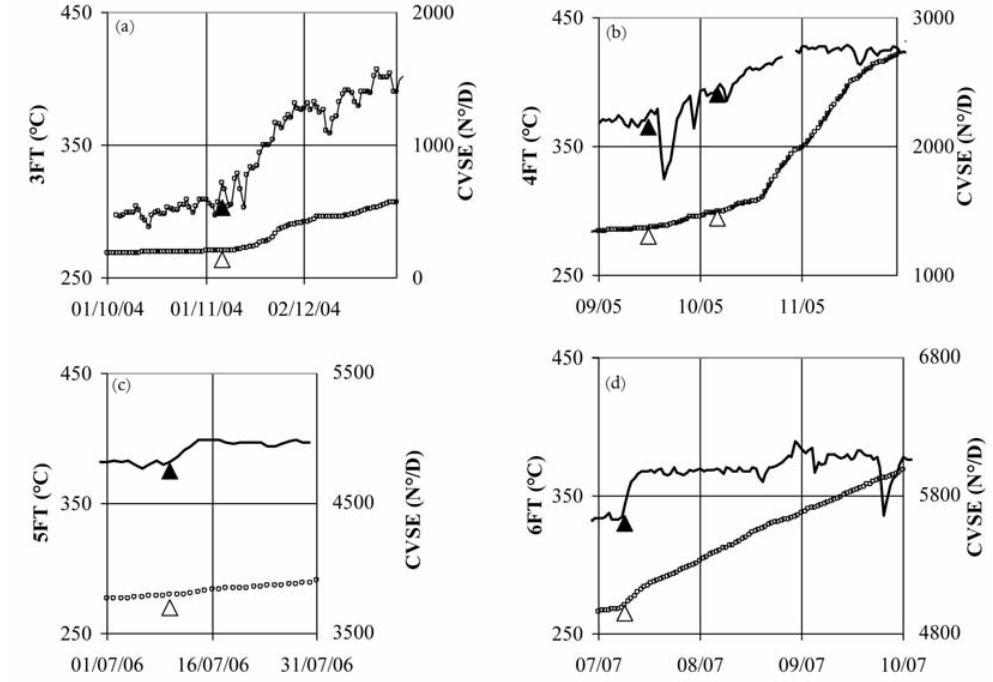
Figure 11. Details from Figure 9a for the onsets of each temperature peak. The black triangles on the temperature curves (FT) and the open triangles on the cumulative curve for the volcano-seismic events (CVSEs) indicate the starting dates for the increases in temperature. See Table 1 for dating and details. (a, b) For 3 FT and 4 FT, where the slope changes for the CVSE occur after the onset of the temperature peak. (c) For 5 FT, where no slope change is seen for the CVSE. (d) For 6 FT, where the slope change for the CVSE occurs at the same time as the fumarole temperature increases (July